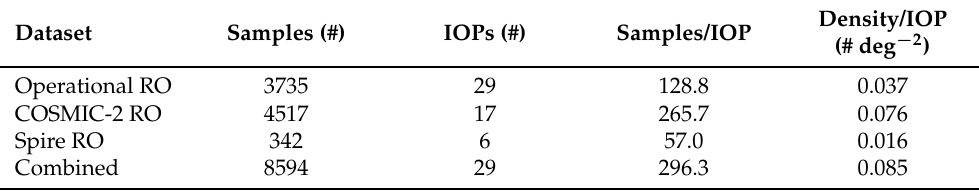
Table 1. Observation sampling and density by dataset.